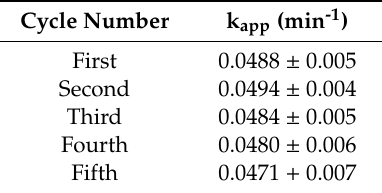
Table 4. Pseudo first-order rate constants ( k app ) for E. coli inactivation under di ff erent conditions consistent with Figure 11.